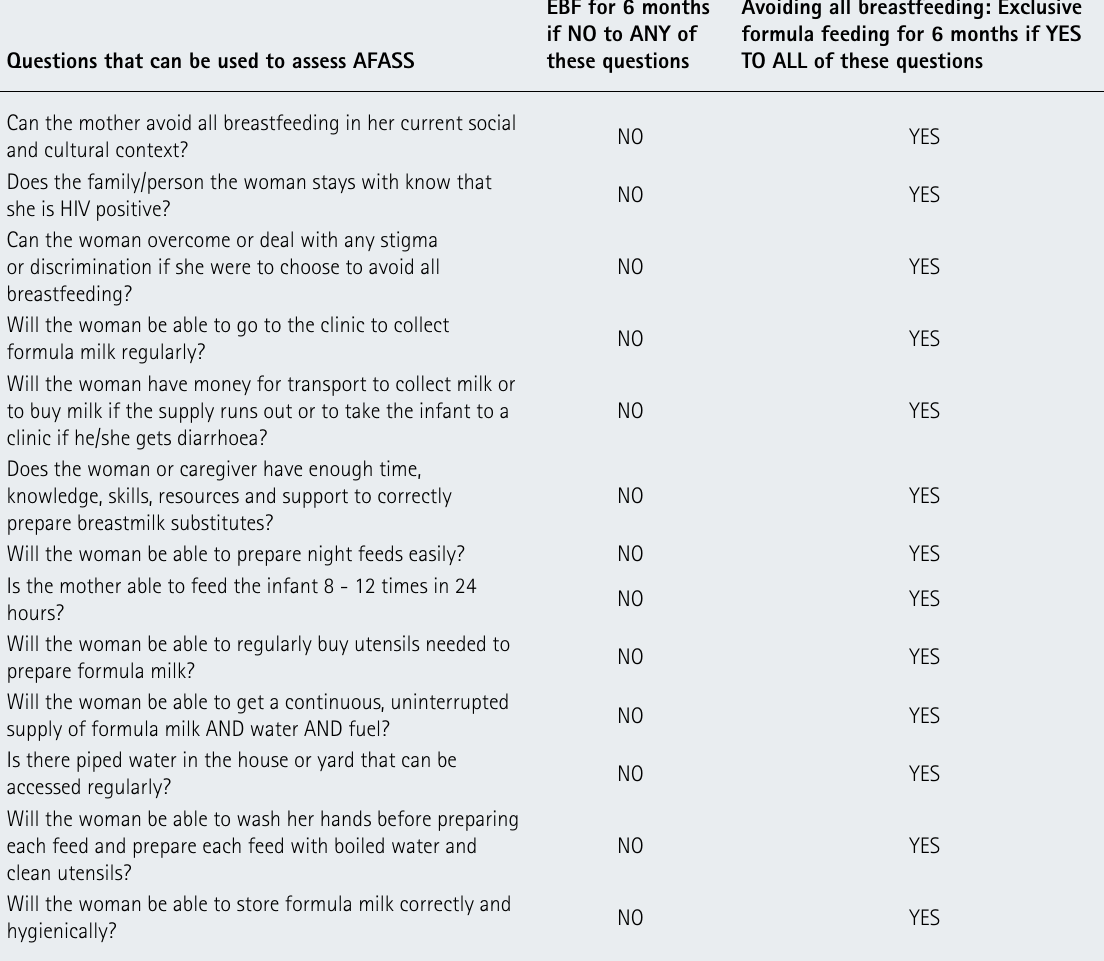
TABLE II. ASSESSING AFASS